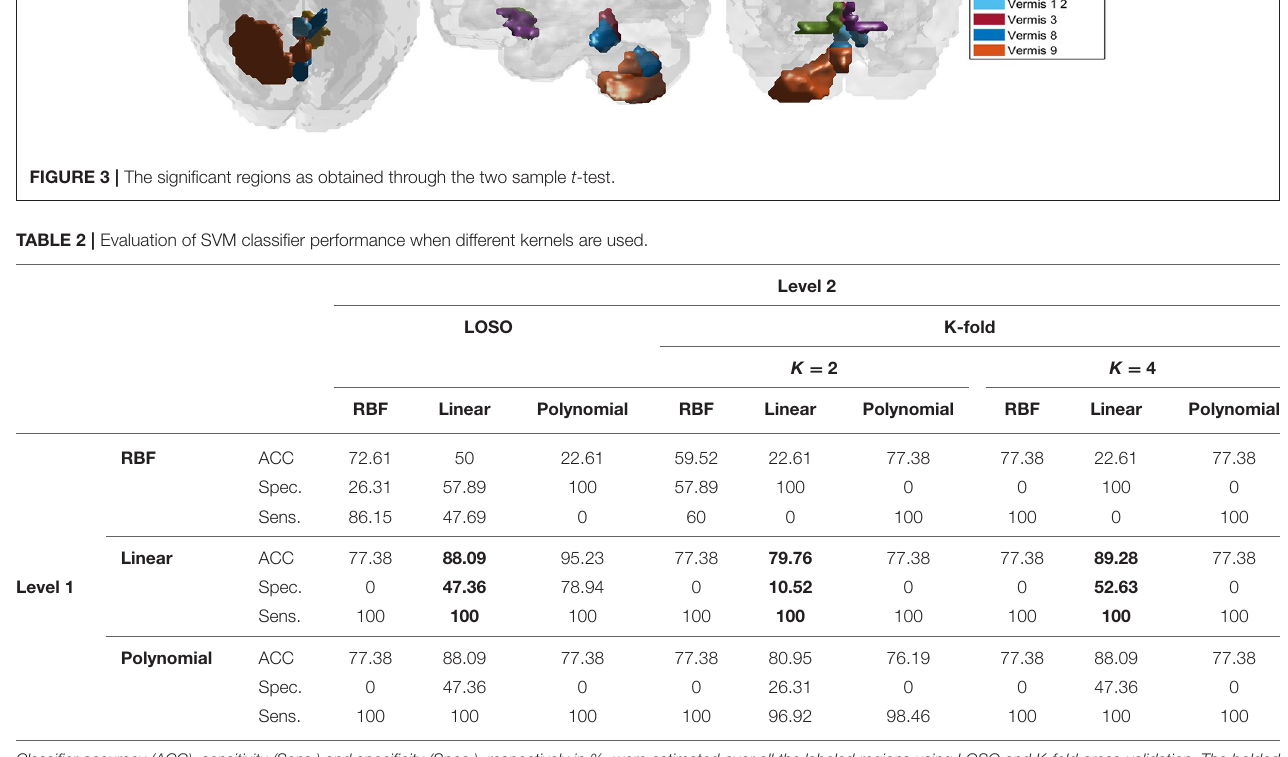
TABLE 2 | Evaluation of SVM classifier performance when different kernels are used.